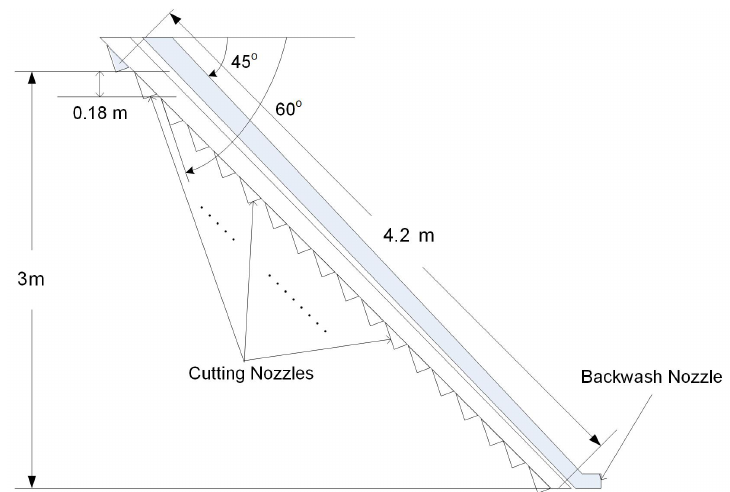
Figure 9. Example of a jetting arm configuration.